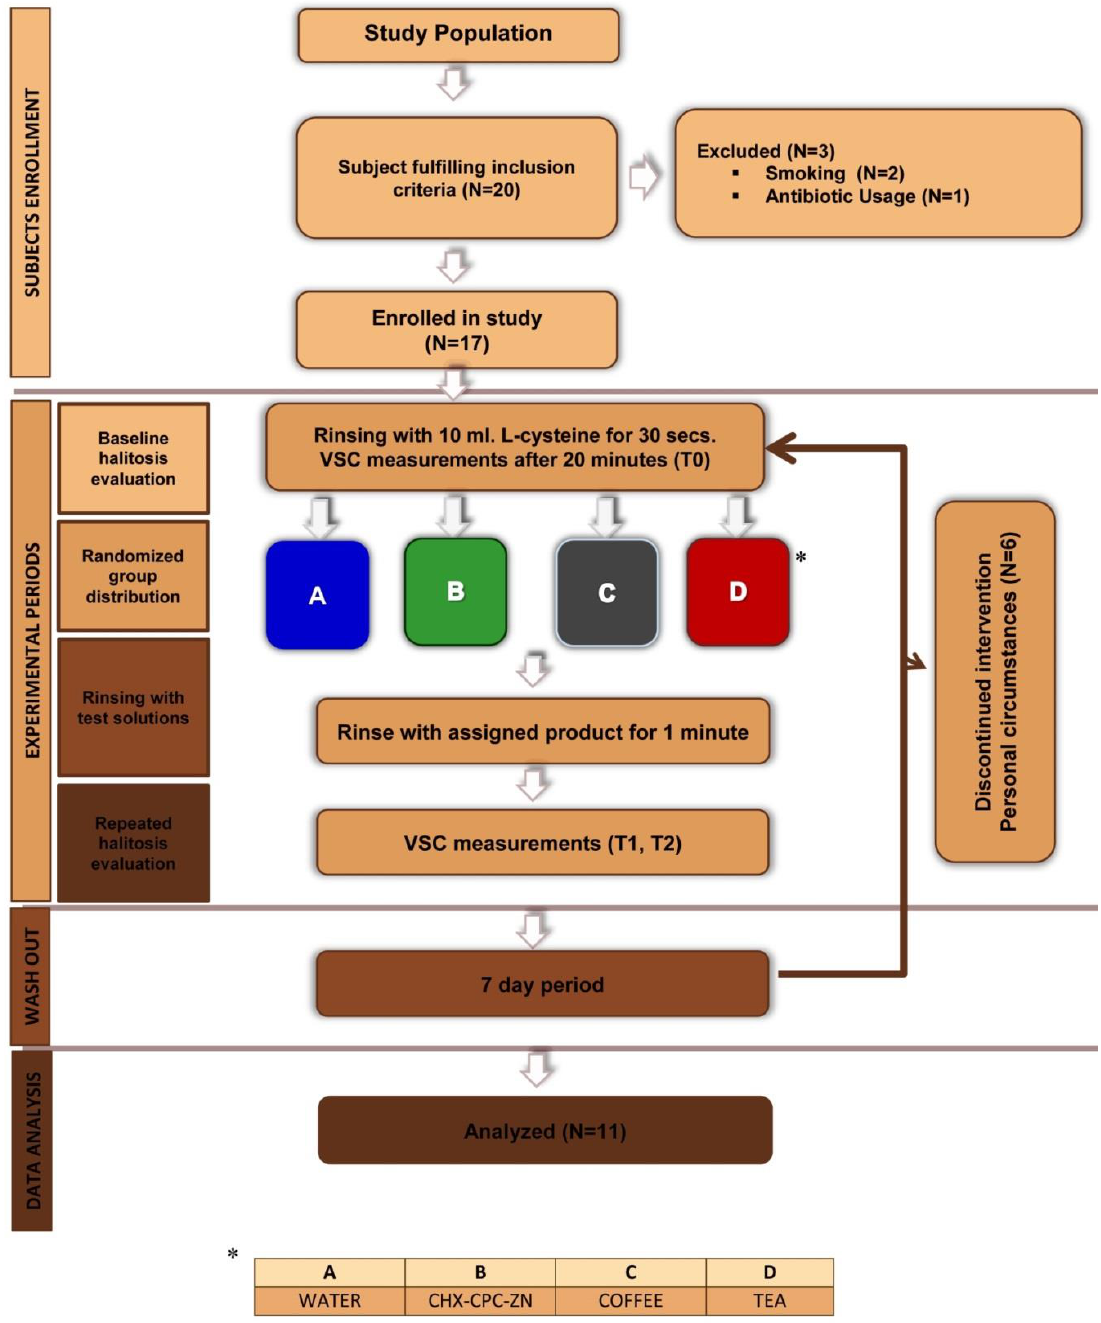
Figure 1. Consort flowchart of the study inclusion, allocation, and follow-up.